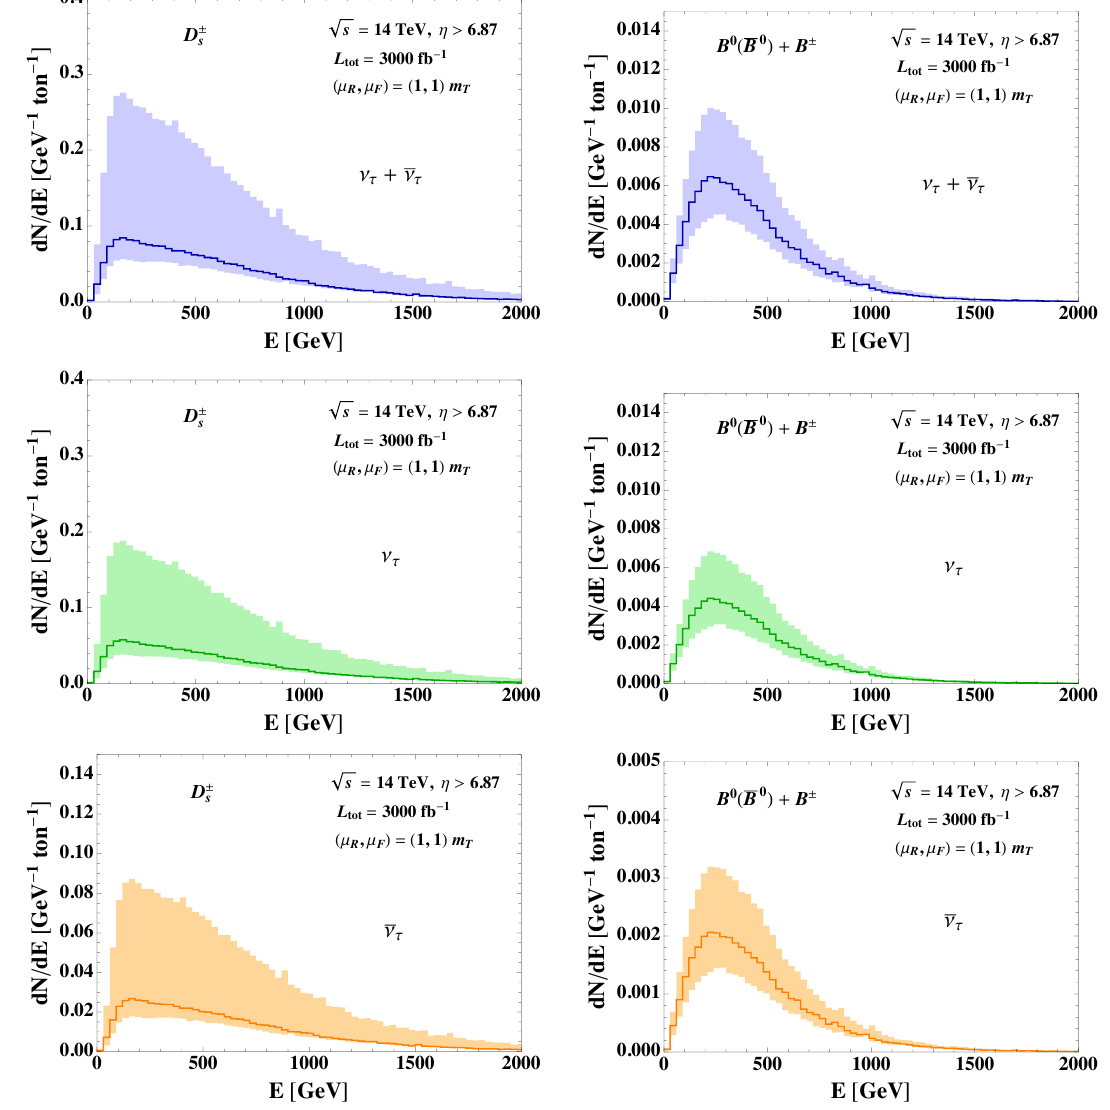
Figure 7 . The same as (cid:12)gure 6, but adopting the central scale conventional choice ( (cid:22) R ; (cid:22) F ) = (1 : 0 ; 1 : 0) m T and seven-point scale variation around it, again with h k T i = 0.7 GeV. to the scale uncertainty to get a total uncertainty for the number of events. In any case, the scale uncertainty yields a range of number of events that is signi(cid:12)cantly larger than the range found by varying h k i from 0 to 2.2 T